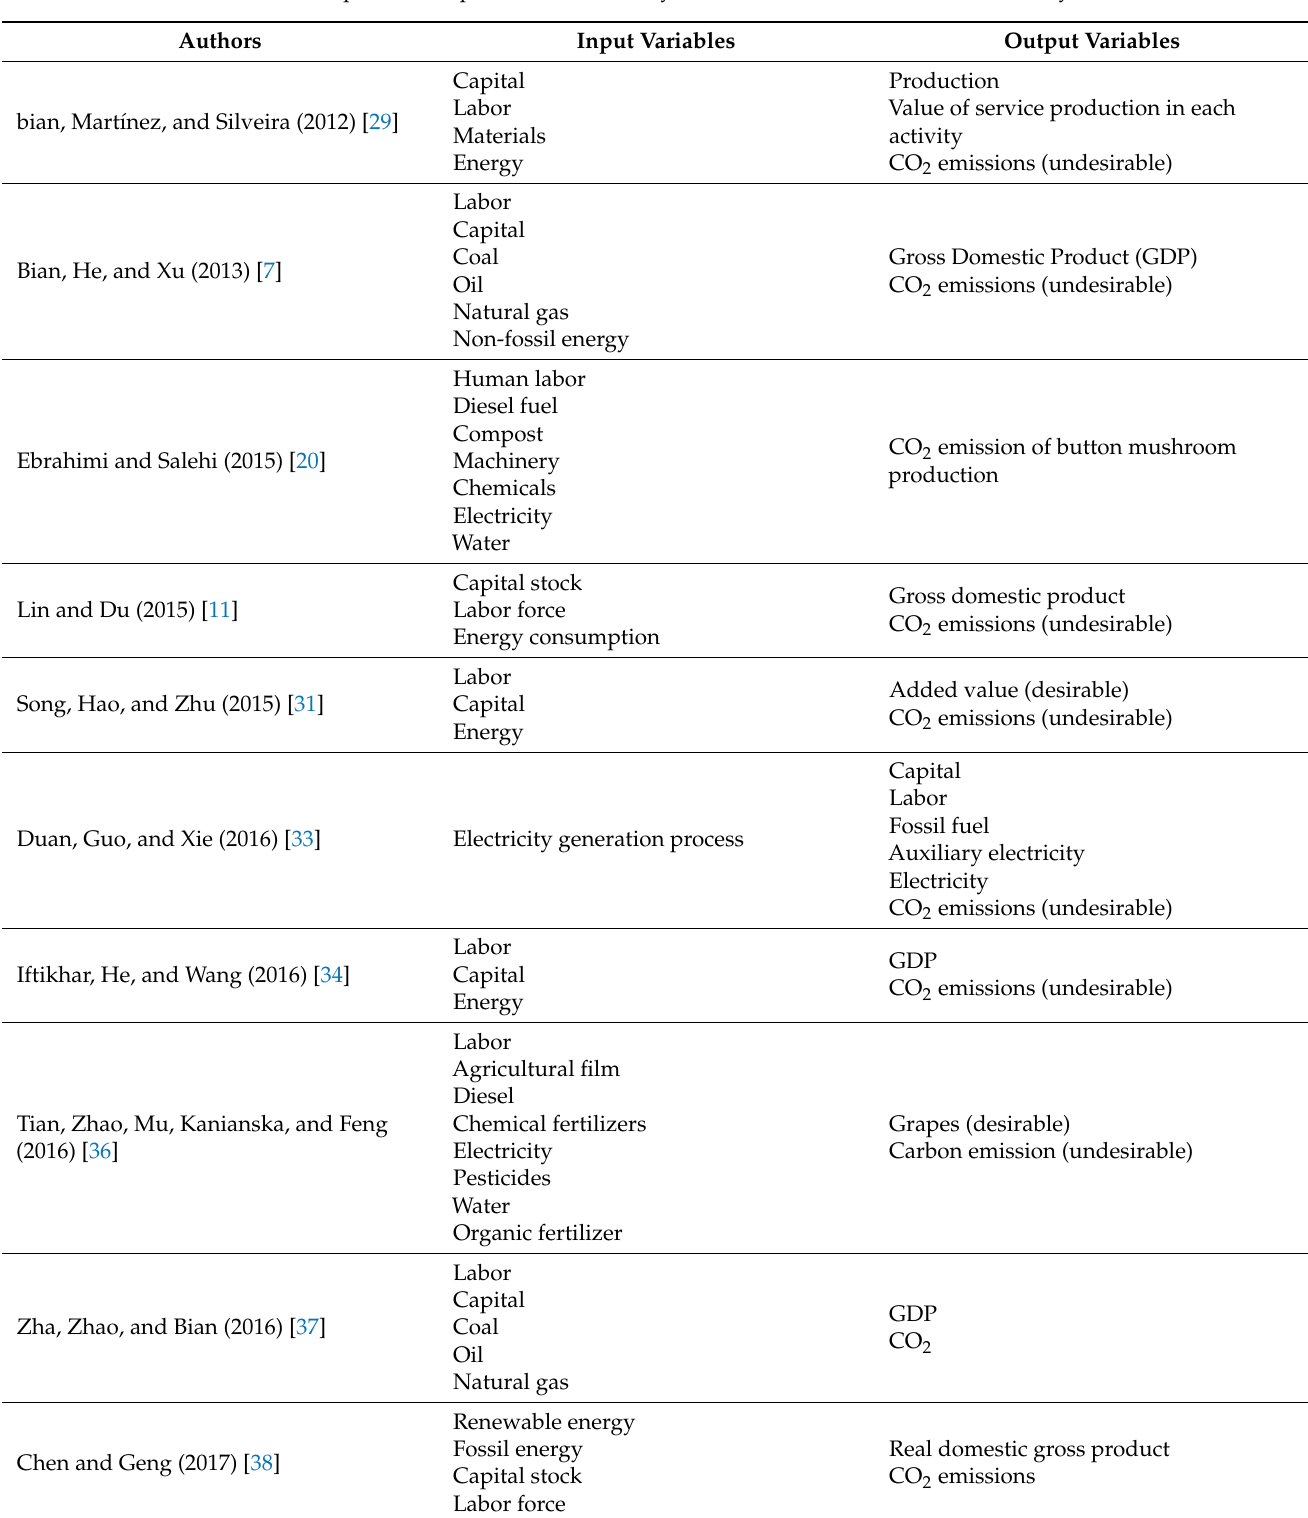
Table 1. Input and output variables used by researchers on environmental